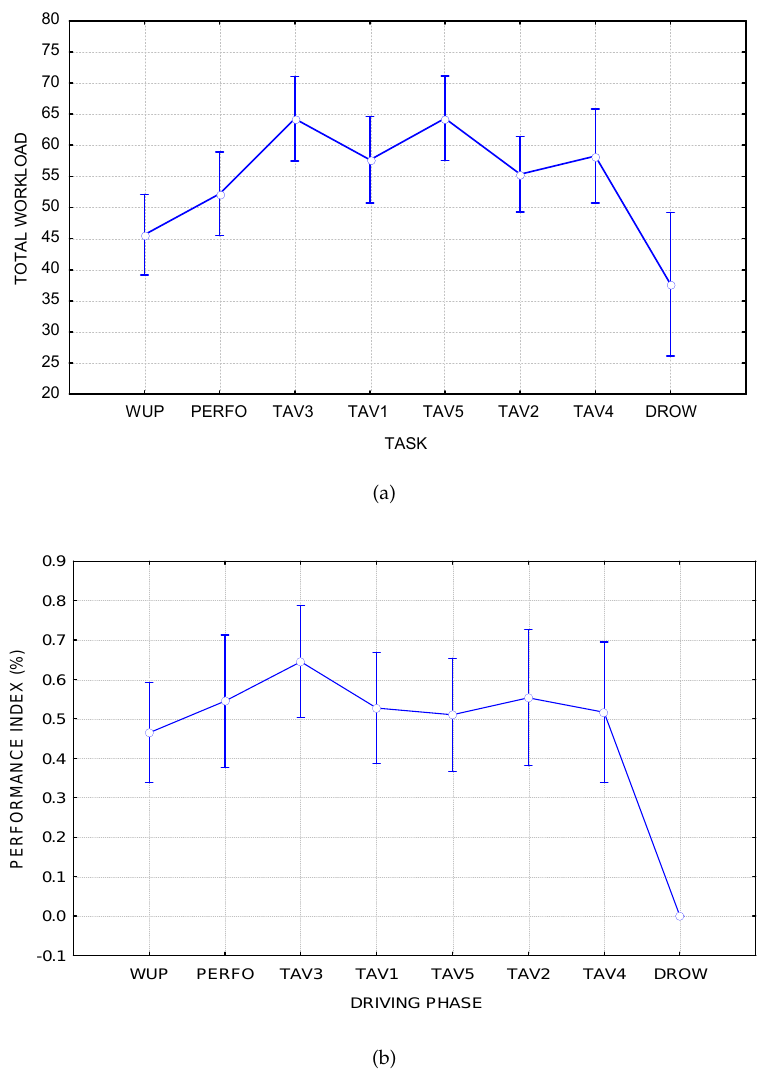
Figure 6. Reasons for the choice of TAV3 and DROW as the regressor labels. (( a ) is the process of NASA-TLX (subjective) with p < 1 × 10 − 5 , and ( b ) is the process of Behavioural (Performance) with p < 1 × 10 − 5